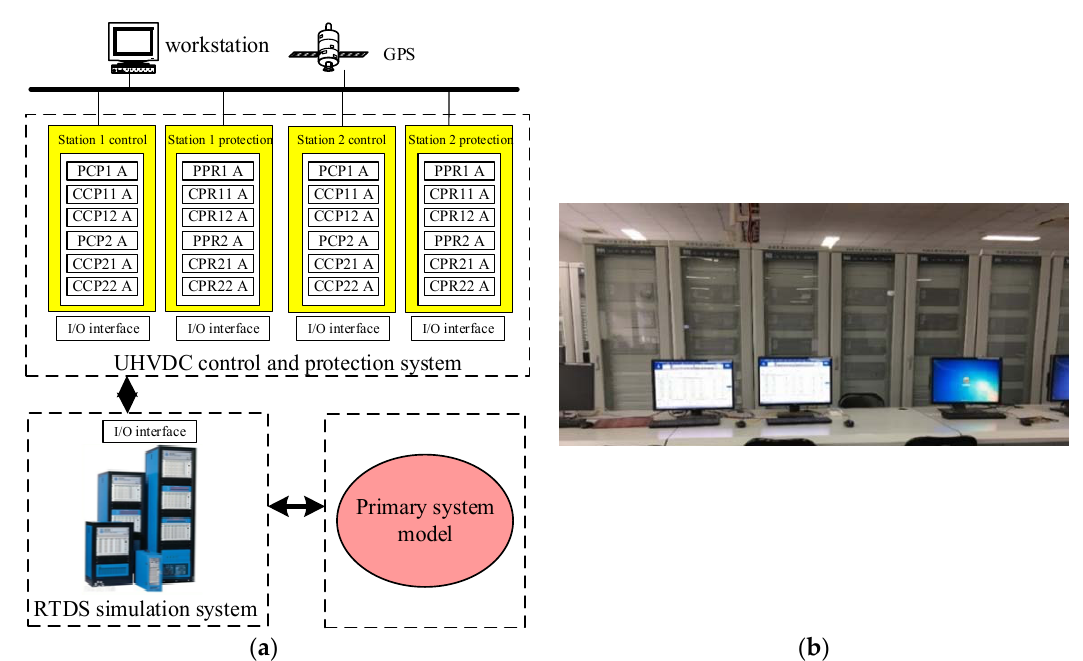
Figure 9. RTDS closed-loop real-time simulation system. ( a ) Principles of closed-loop real-time simulation system; ( b ) UHVDC control and protection system.